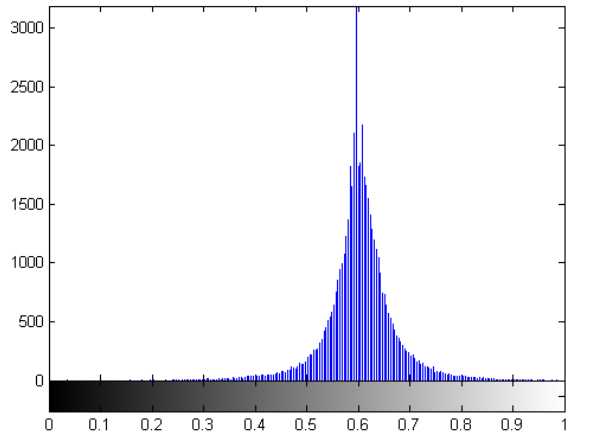
Figure 6. Pixel histogram for (cid:102) ( β , m , n ) using the test